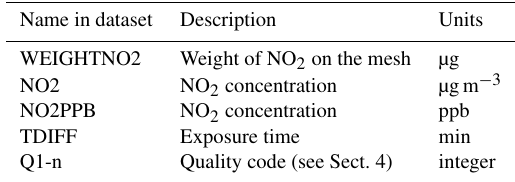
Table 4. Atmospheric chemistry